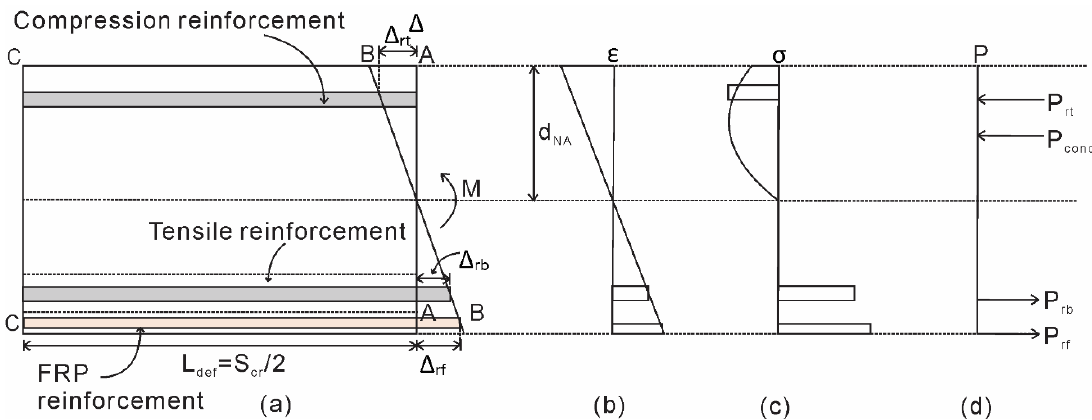
Figure 6. Hinge analysis procedure. ( a ) Beam section; ( b ) Strain profile; ( c ) Stress profile; ( d ) Forces acting on beam